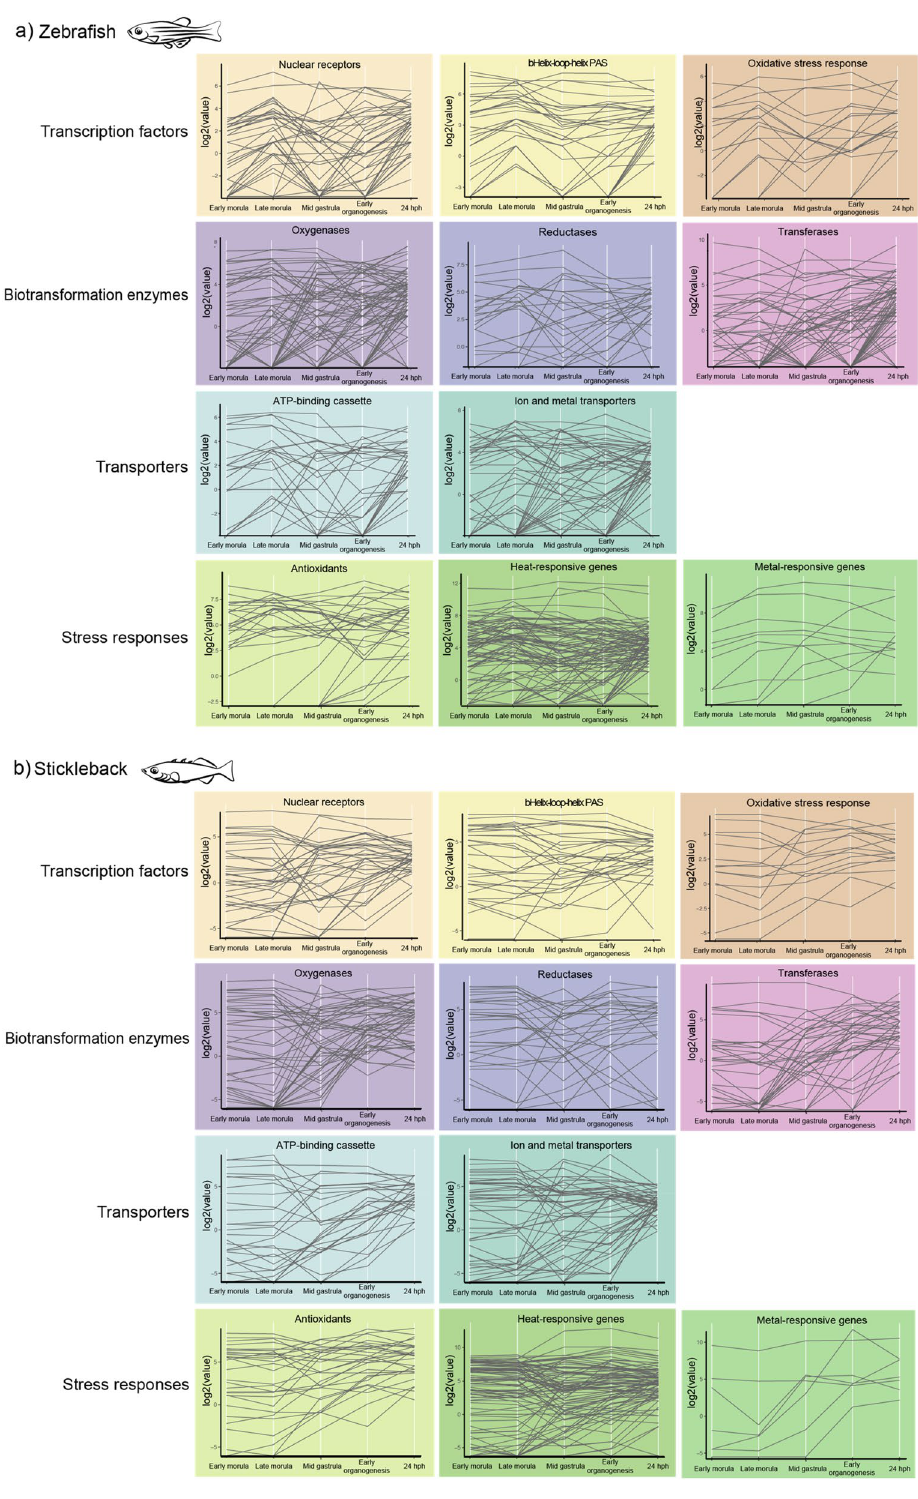
Figure 3. Transcription of chemical defensome genes in early development of ( a ) zebrafish ( Danio rerio ) and ( b ) stickleback ( Gasterasteus aculeatus ). Absolute transcription values (log2 scale) of defensome genes, grouped into their functional category, are shown at early morula, late morula, mid gastrula, early organogenesis, and 24 h post hatching